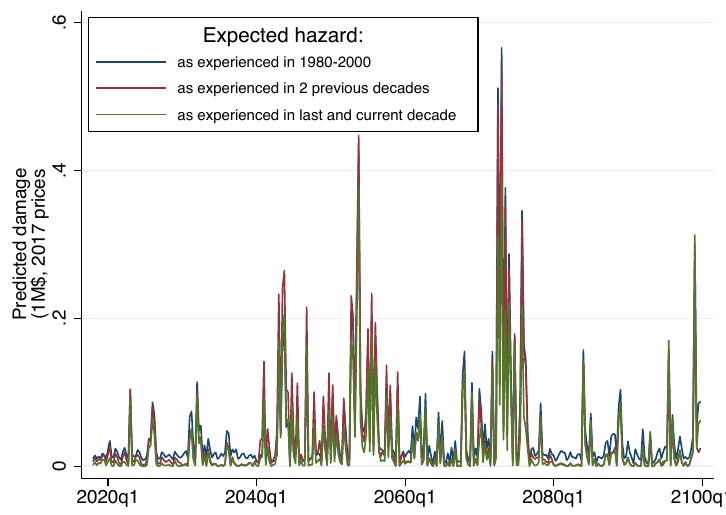
Figure 8. Quarterly flooding damage until 2099 in CRB. Predicted average levels in census blocks by hazard expectation